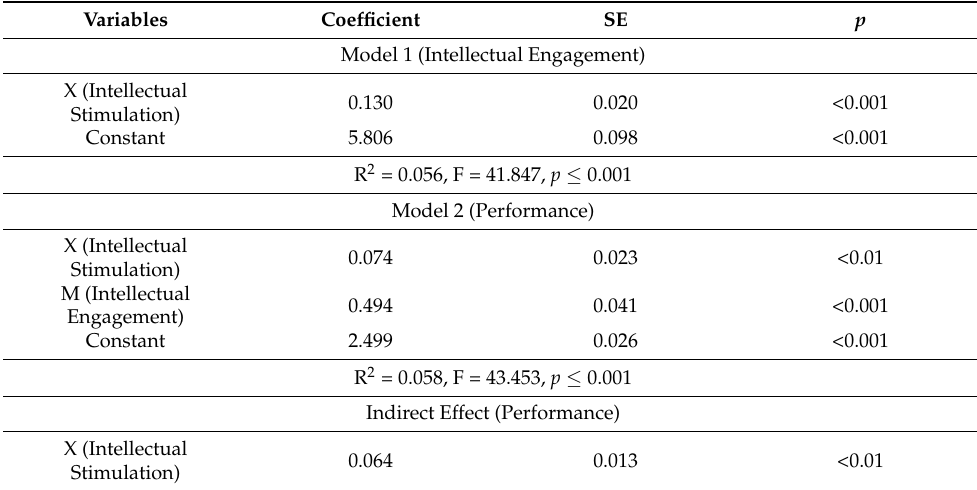
Table 2. Results from the regression analyses examining the mediator model of the influence of intellectual stimulation (X) on performance (Y) through intellectual engagement (M1).